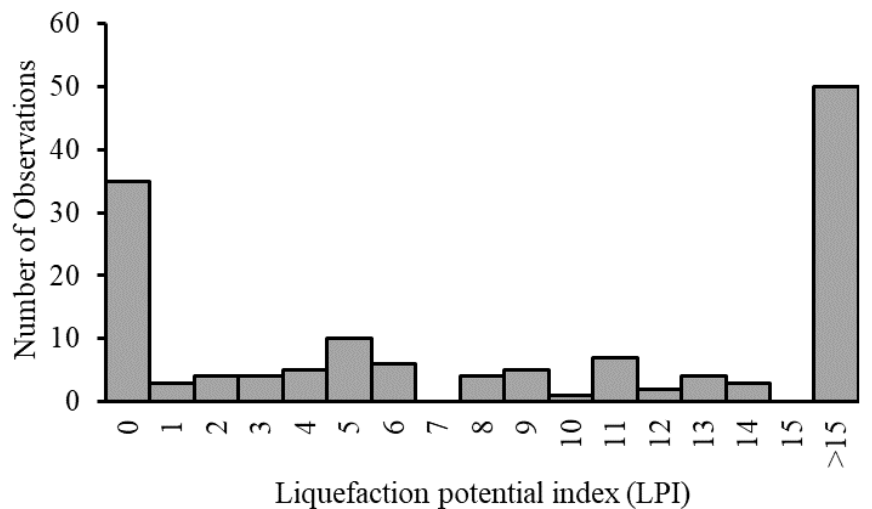
Figure 10. The histogram of liquefaction potential index values.